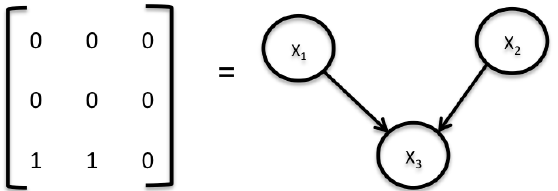
Figure 2. Example of an adjacency matrix and its corresponding BN.